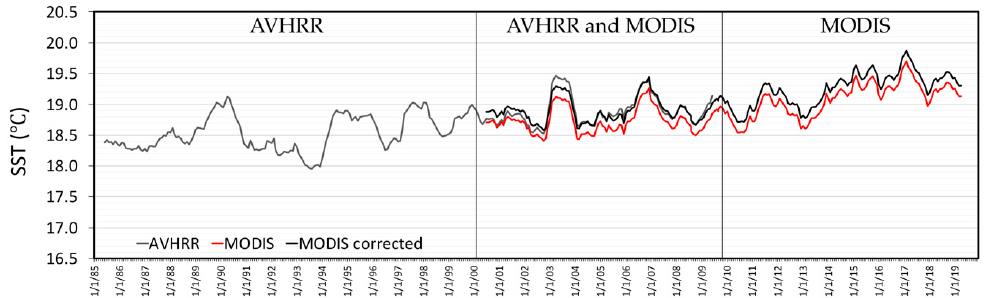
Figure 6. A 12-month moving average time series of SST in the Western Mediterranean between 1985 and 2019 obtained from the combination of monthly data from AVHRR (1985–2009), in grey, and MODIS (2000–2019), in red. In black are the MODIS data corrected for the average deviation per month between the sensors.